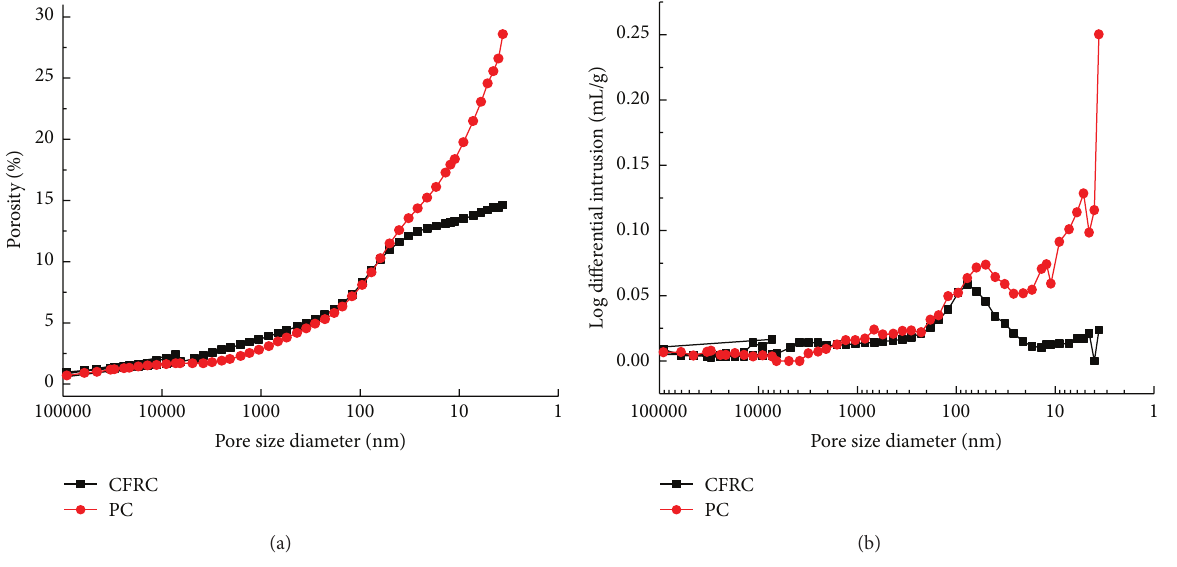
Figure 14: Pore size distributions of CFRC and PC at room temperature (20 ∘ C).